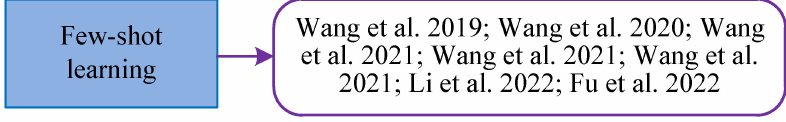
Figure 16. Few-shot learning used in SAR ATR